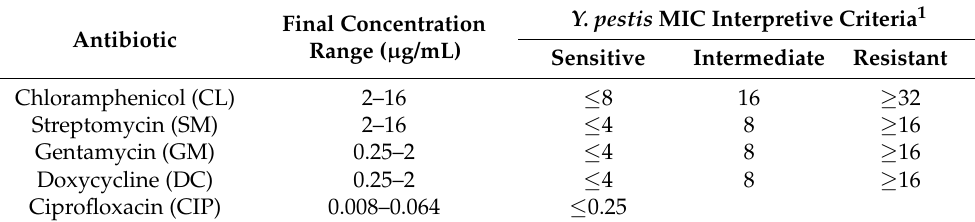
Table 2. Antibiotic concentrations and Y. pestis MIC interpretive